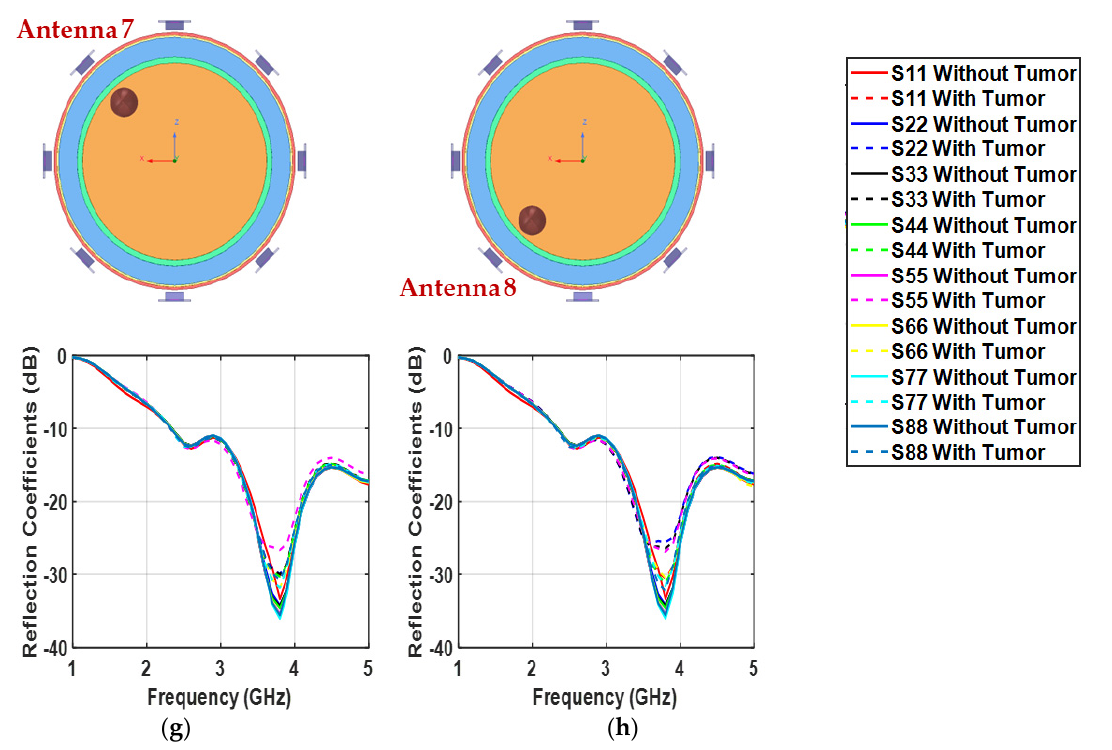
Figure 9. Comparison between reflection coefficients of healthy and unhealthy phantoms when a 15 mm radius tumor is placed: ( a ) near antenna 1 (Case 1); ( b ) near antenna 2 (Case 2); ( c ) near antenna 3 (Case 3); ( d ) near antenna 4 (Case 4); ( e ) near antenna 5 (Case 5); ( f ) near antenna 6 (Case 6); ( g ) near antenna 7 (Case 7); and ( h ) near antenna 8 (Case 8).